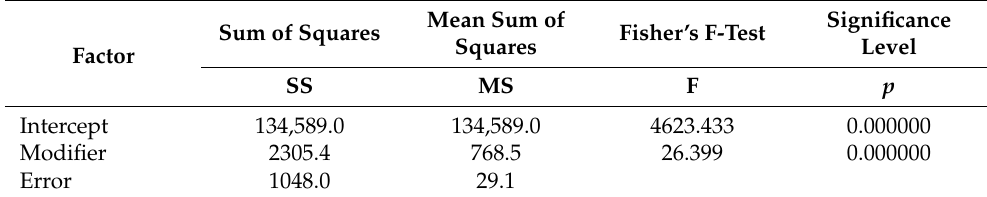
Table 3. Statistical evaluation (ANOVA) of the ions influencing wettability of the bacterial cellulose surface. Significance Mean Sum of Fisher’s F-Test Sum of Squares Level Squares Factor SS MS F p Intercept 134,589.0 134,589.0 4623.433 0.000000 Modifier 2305.4 768.5 26.399 0.000000 Error